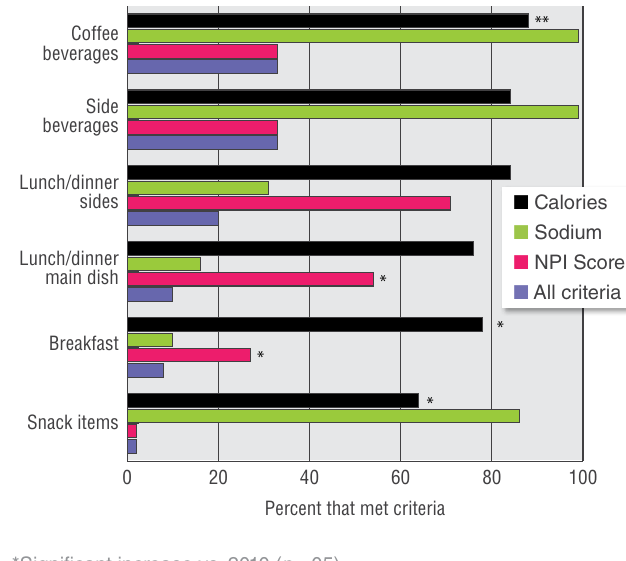
Figure 3. Percent of menu items by type that met nutrition criteria